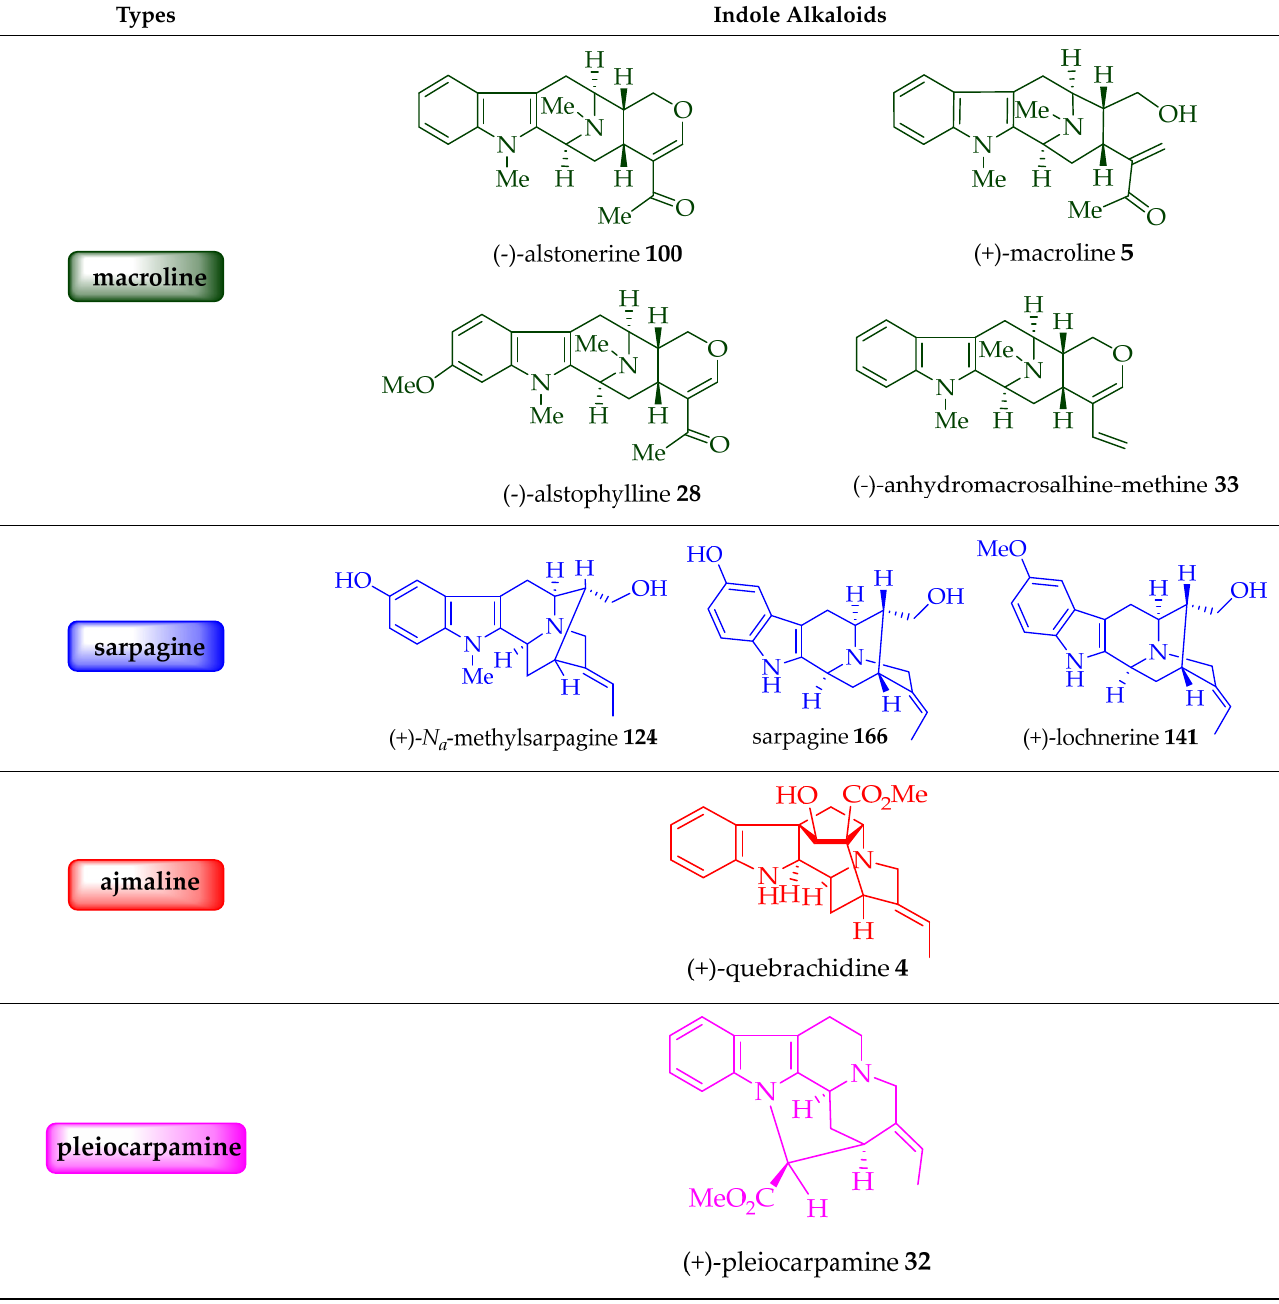
Table 1. Indole alkaloids (monomeric units) in bisindoles from Alstonia species that are reviewed herein. Types